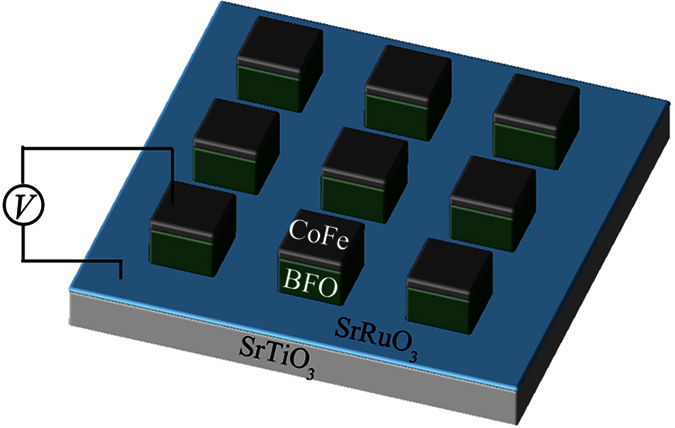
Patterned CoFe/BiFeO3 island heterostructure. Dot CoFe/(110)-island BFO multiferroic heterostructures grown on (110) SrTiO3 substrate with CoFe and SrRuO3 as the top and bottom electrodes, respectively.